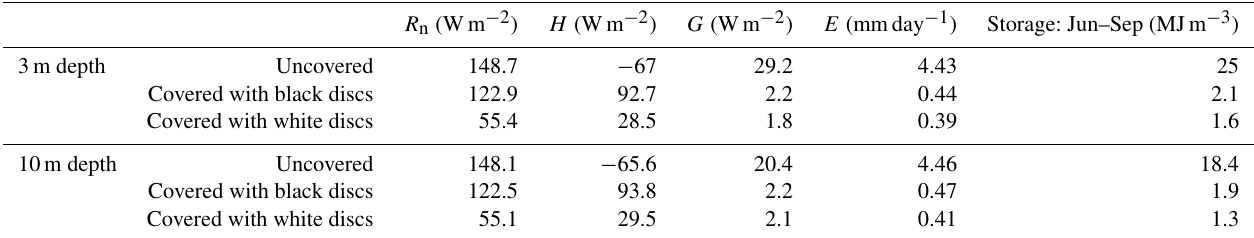
Table B1. The effect of reservoir depth on heat fluxes and specific storage of uncovered and covered